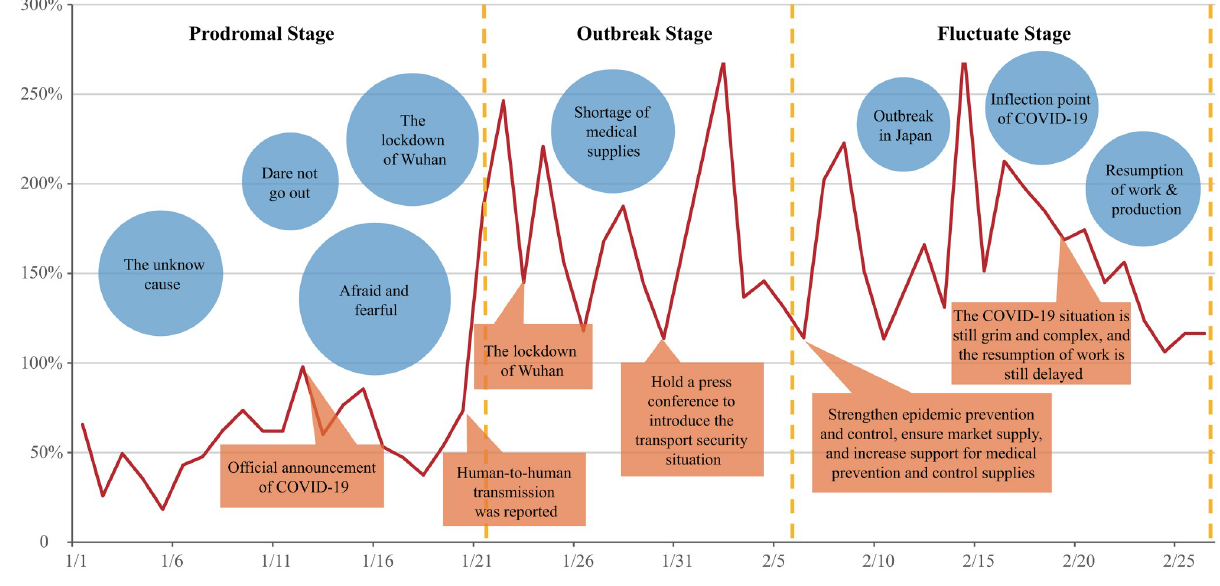
Fig 4. Topic analysis of public sentiments during COVID-19